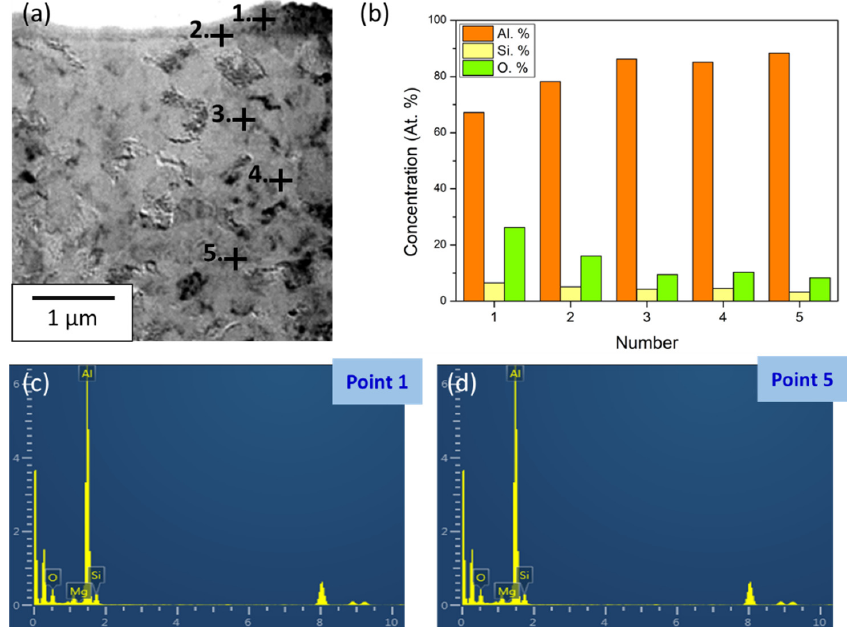
Figure 11. ( a ) EDS sampling point, ( b ) changes of the element concentrations at different points, and the element pattern of ( c ) point 1 and ( d ) point 5.